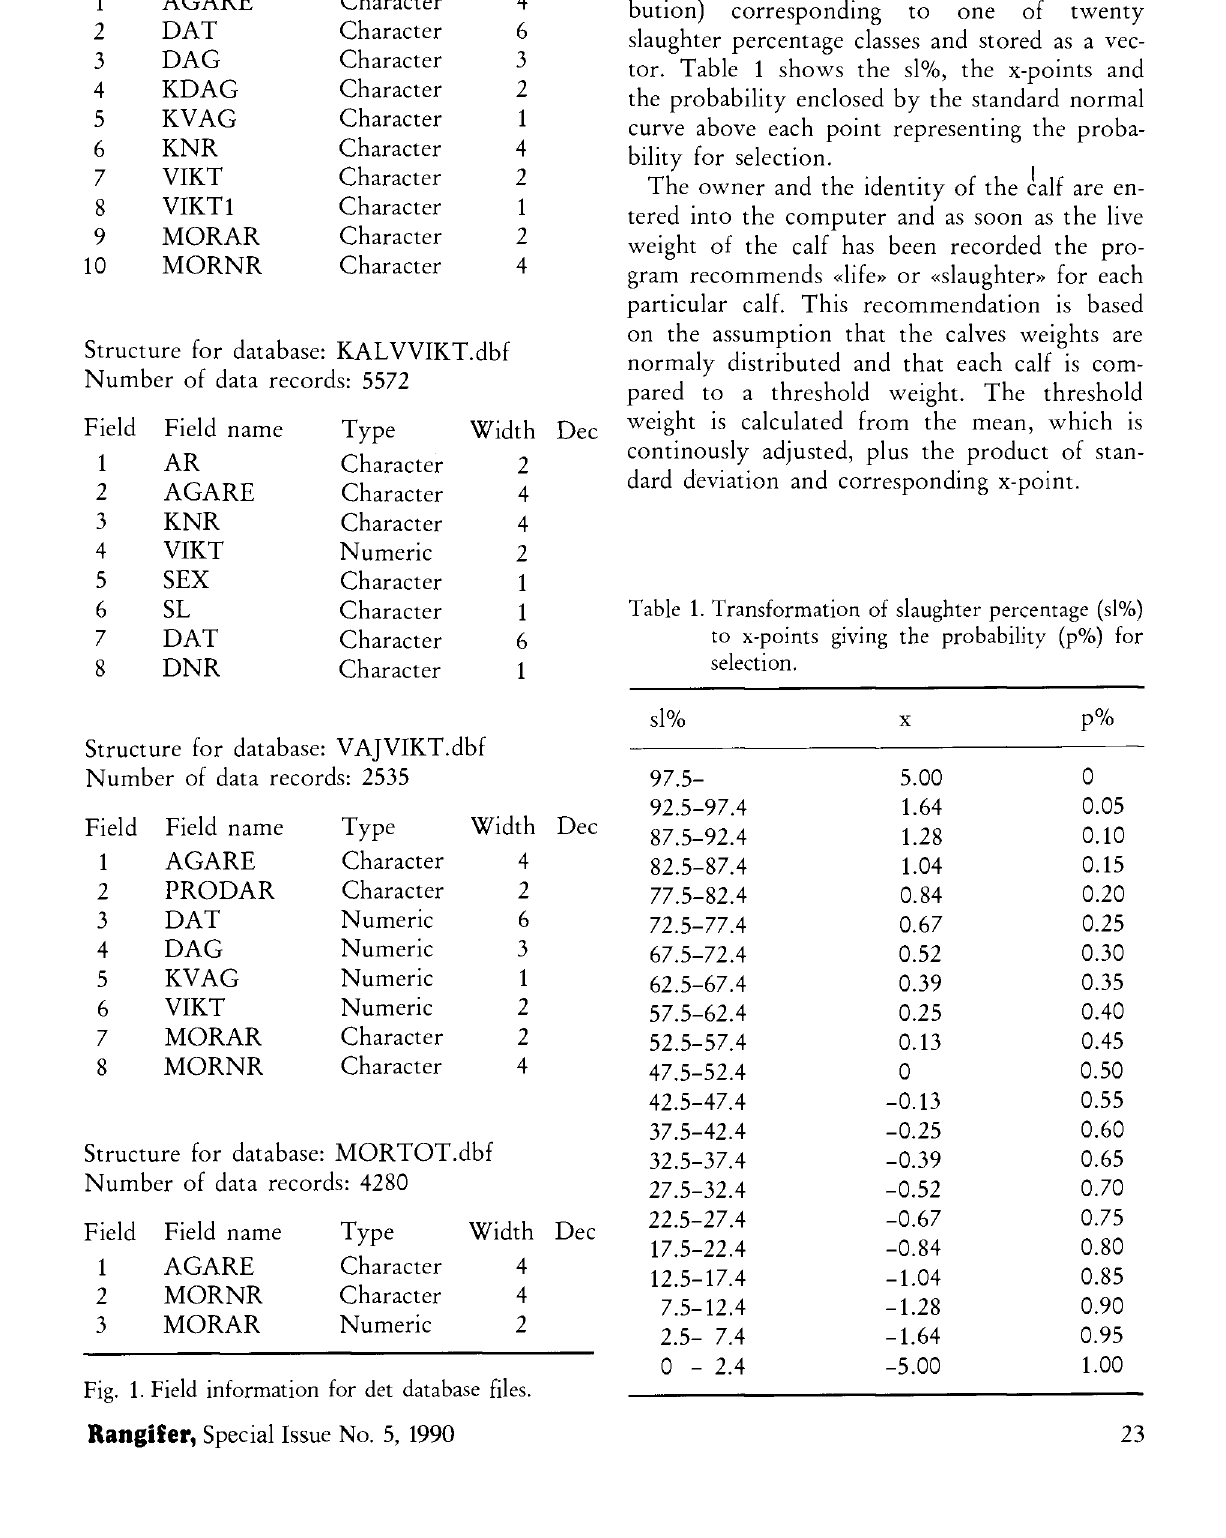
Table 1. Transformation of slaughter percentage (sl%) to x-points giving the probability (p%) for selection.